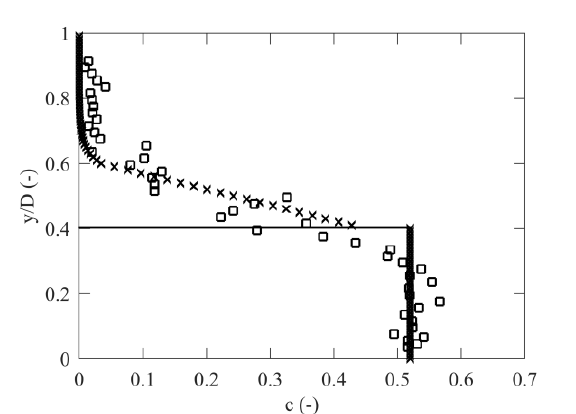
Fig. 3. Distribution of granular concentration at velocity slightly above deposition limit for flow of SP090 slurry ( C vd,max = 0.26) at pipe inclination of -15 deg, V m = 1.1 m.s -1 , C vd = 0.093. Legend: square = experiment, x = model prediction.